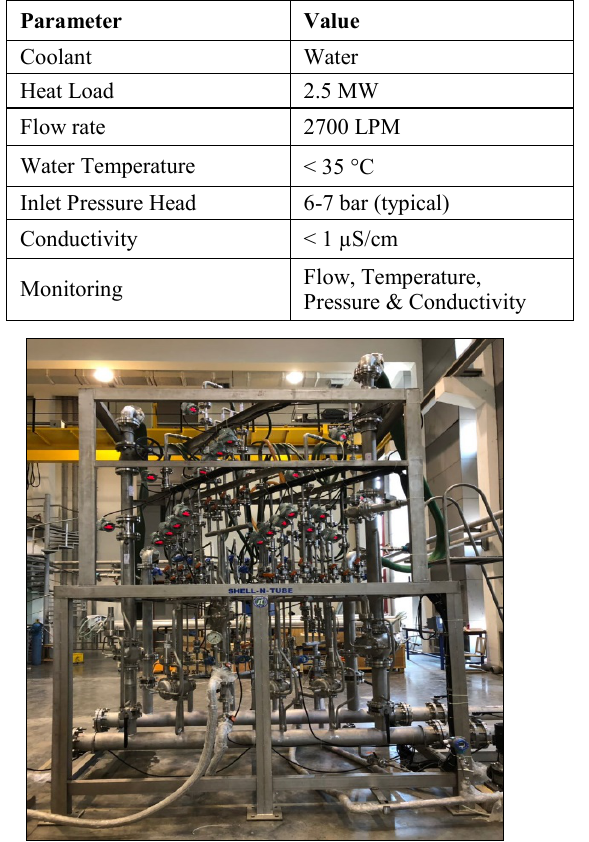
Fig. 17 : Gyrotron Cooling Distribution Manifold